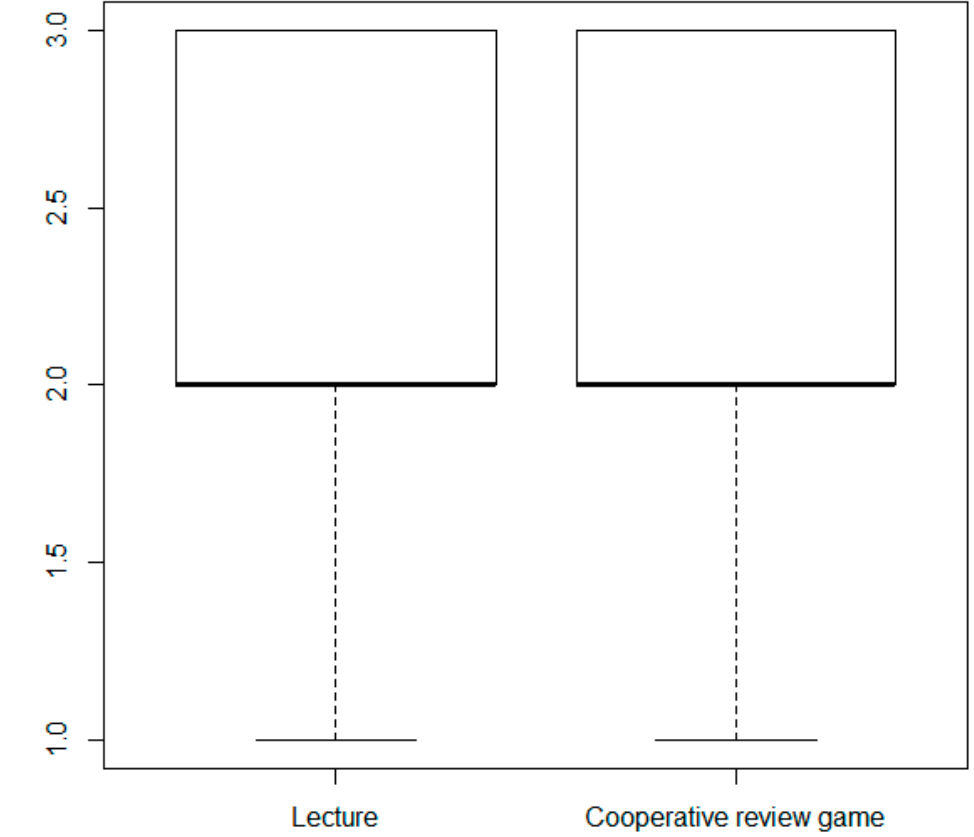
Figure 6. Responses to the question “The activity helped me to see which contents are / have been the most relevant”.